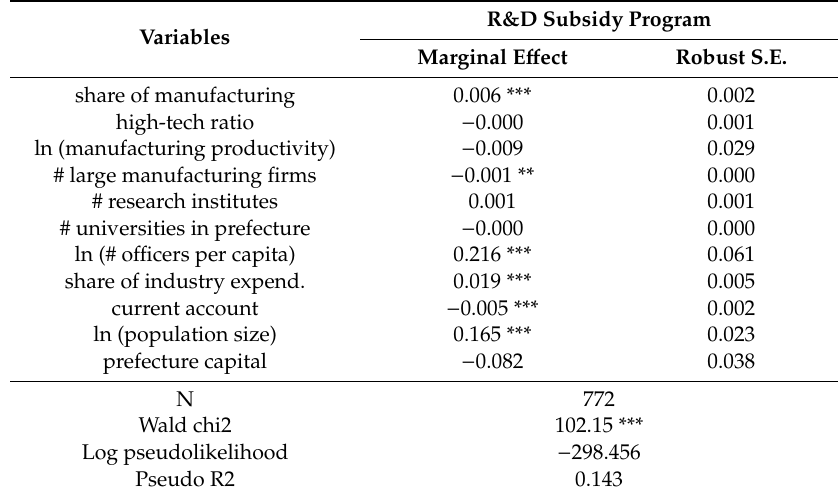
Table 3. Estimation results on the propensity of the R&D subsidy program (probit